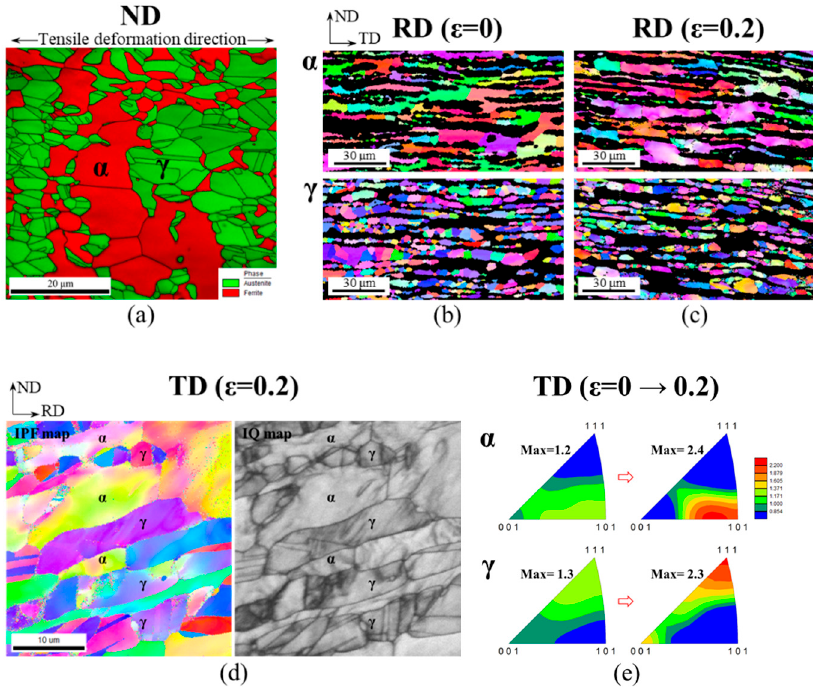
Figure 2. ( a ) Electron backscatter diffraction (EBSD) phase distribution map in normal direction (ND) of as-received specimen. Inverse pole figure (IPF) distribution map in rolling direction (RD) ( b ) with as-received state, ( c ) with 0.2 of tensile strain. ( d ) IPF and image quality (IQ) map and ( e ) inverse pole figure along the tensile axis direction. Table 2. Microstructural properties of the specimen.